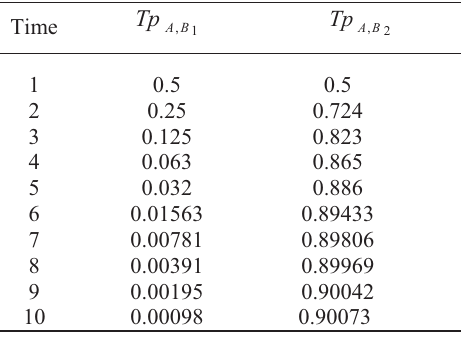
Table 1. Variation of trust pheromone between A and B with time and interactions.